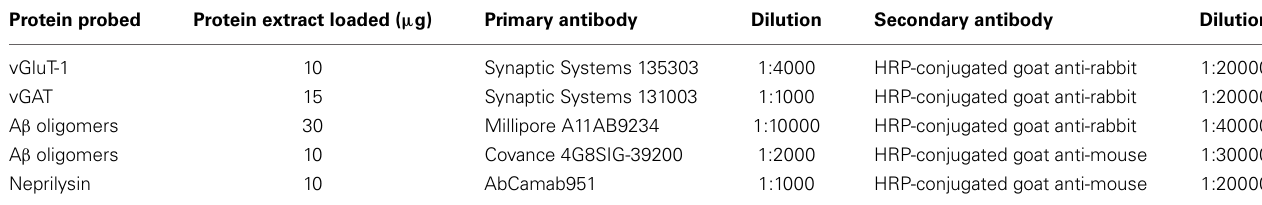
Table 1 | Antibodies, dilutions and amount of protein loaded in Western blot assays. Protein